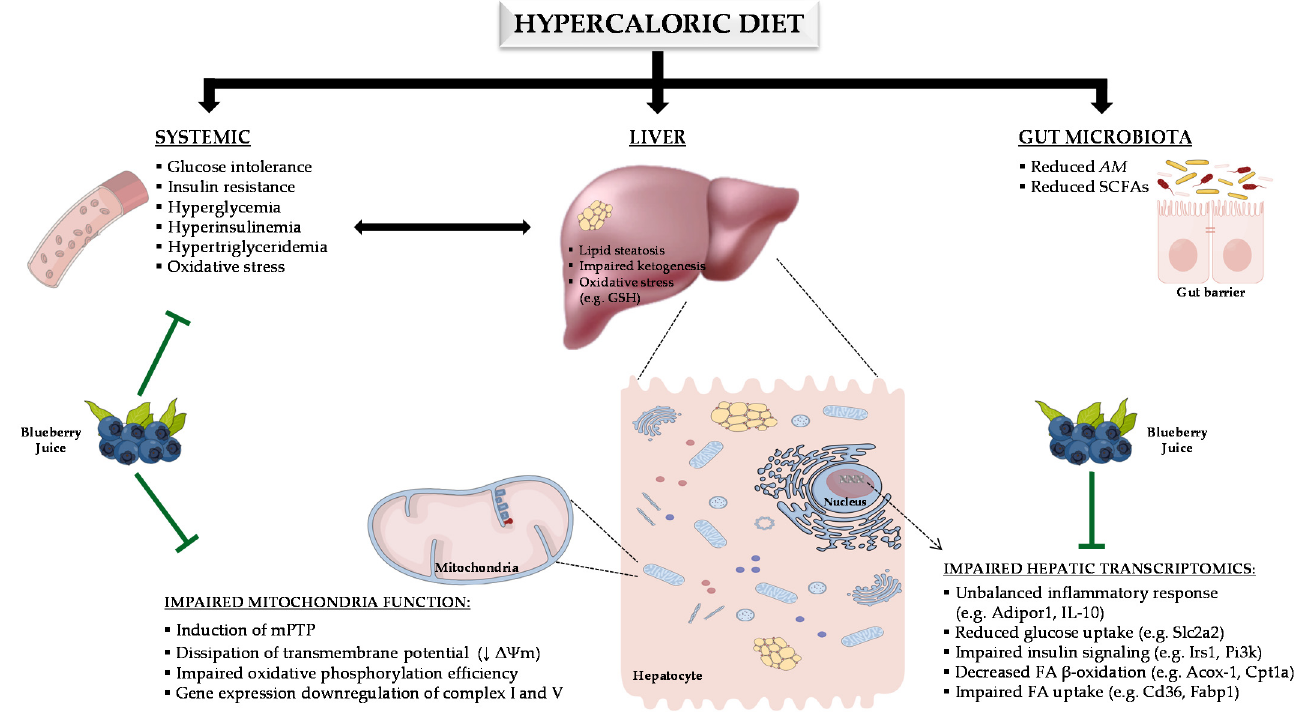
Figure 9. Blueberry counteracts the hypercaloric diet-evoked metabolic dysregulation by improving the glycemic, insu- linemic, and lipid profile along with reduced hepatic steatosis. Moreover, together with restoring systemic and hepatic antioxidant metabolites, BBs positively modulate the gene expression of key targets of inflammation, insulin signaling, and fatty acid metabolism as well as rescuing the mitochondria function in the liver. Abbreviations: AM , Akkermansia muciniphila ; FA, fatty acids; SCFAs, short-chain fatty acids; mPTP, mitochondrial permeability transition pore. ⊥ protective/inhibitory effects induced by BJ.